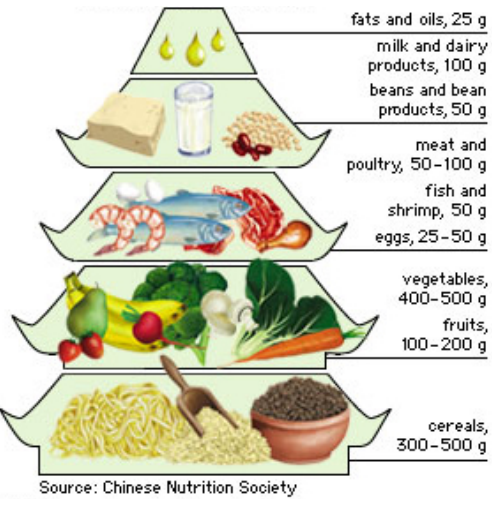
Figure 2. Food guide pagoda.